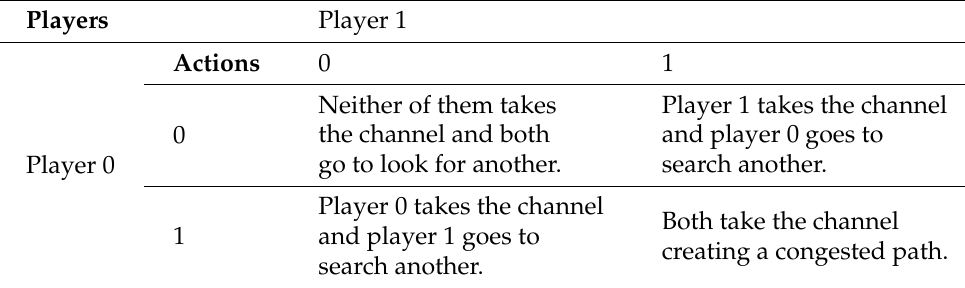
Table 1. Example of two packets interested in the same channel.